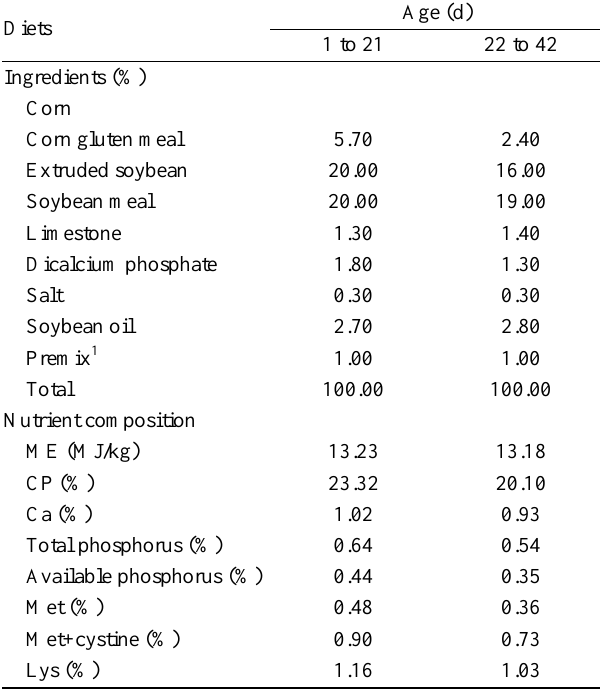
Table 1. Composition and nutrient content of basal diets in different growing